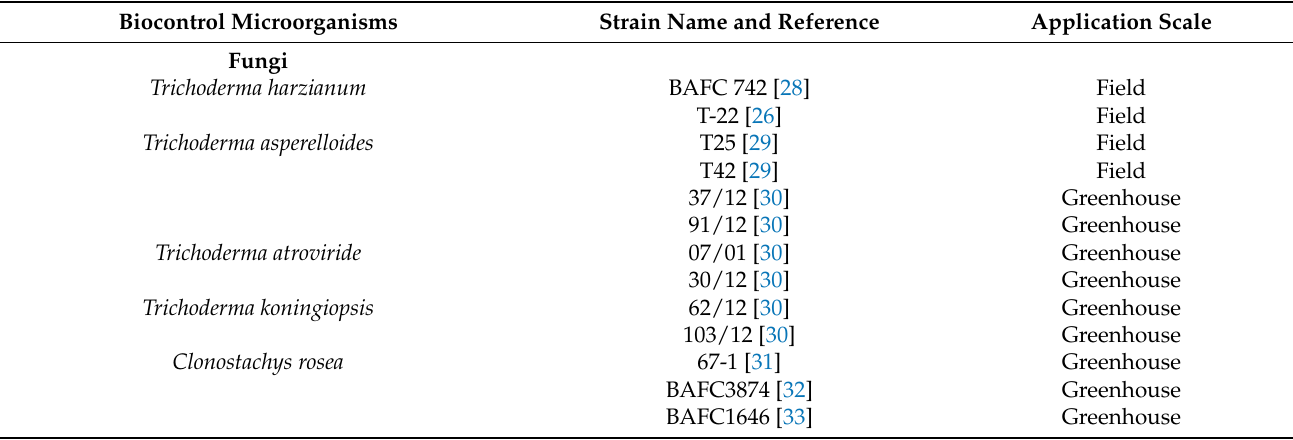
Table 1. Overview of biocontrol agents showing control ability against